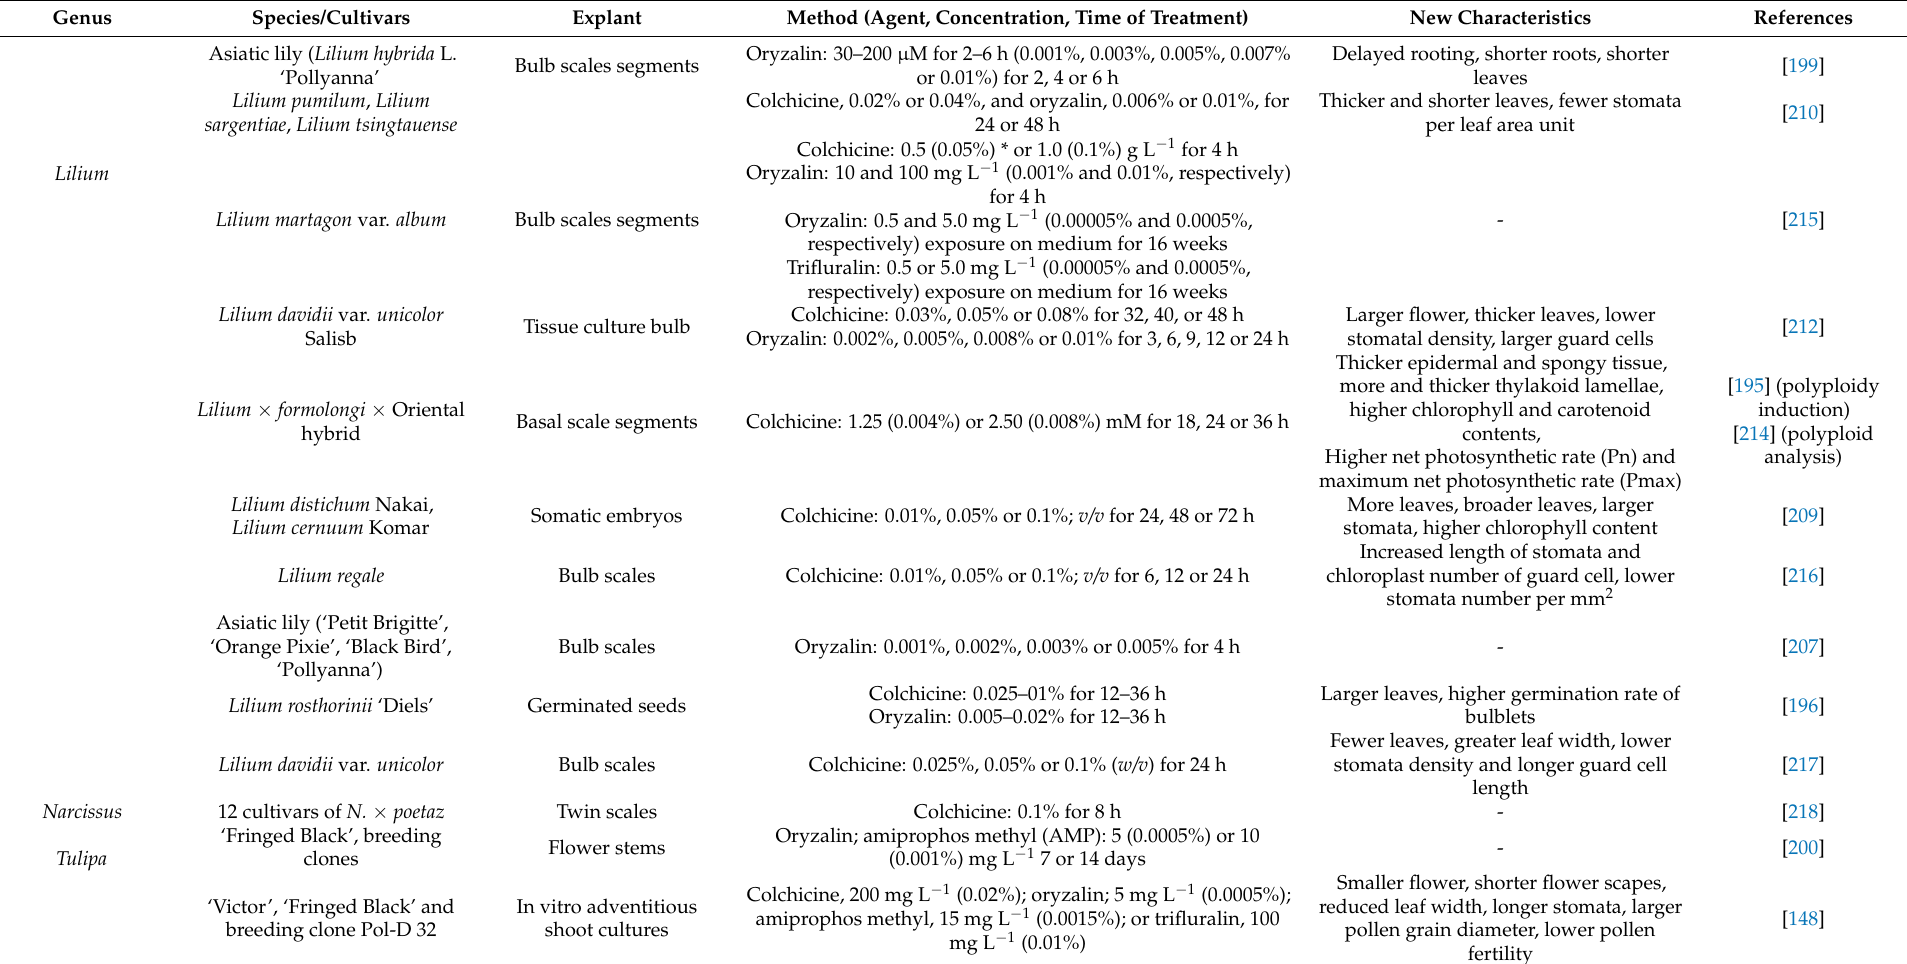
Table 2. Recent reports on mitotic polyploidisation in selected ornamental bulbous